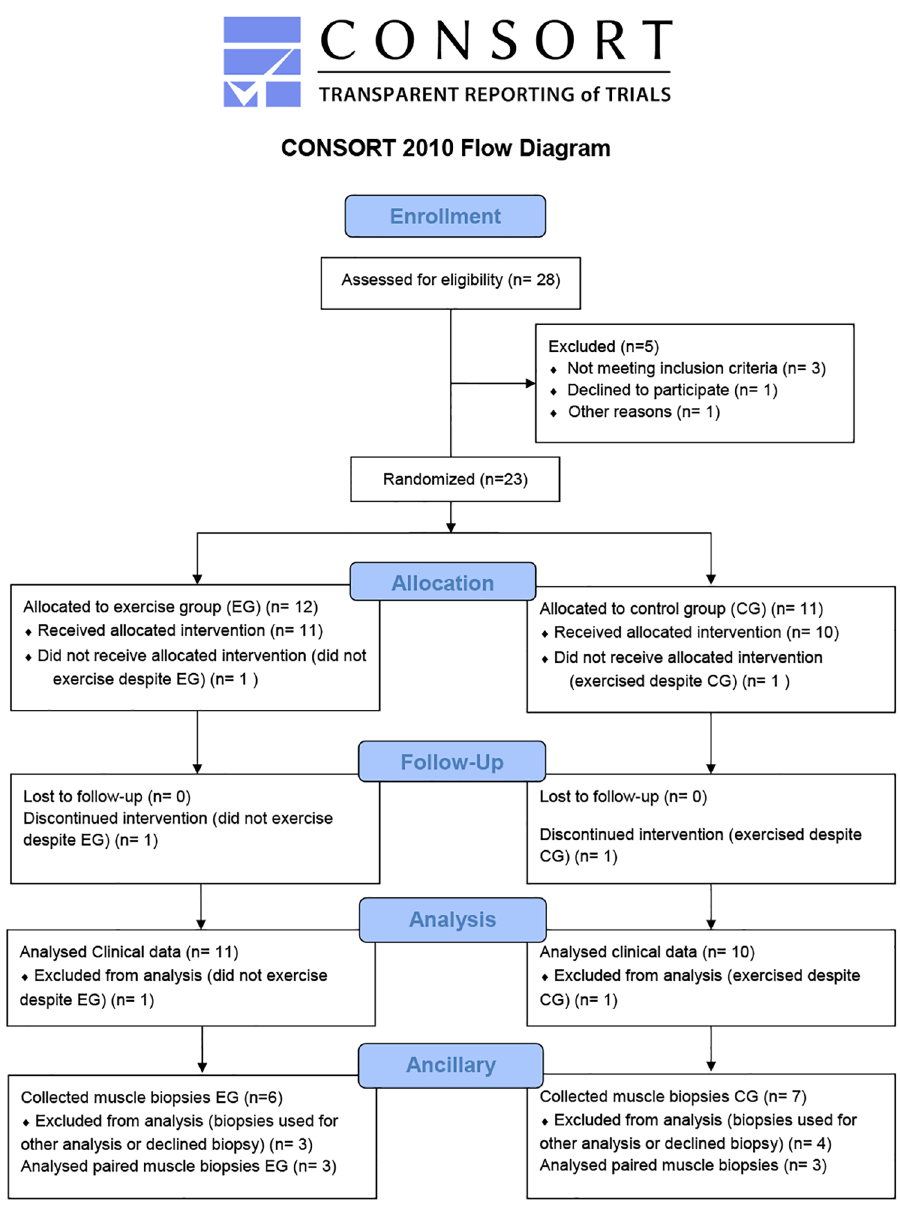
Fig 1. CONSORT 2010 flow diagram. The flow chart depicts the numbersof participantswho were randomly assigned,exercised,and were analyzedfor study.